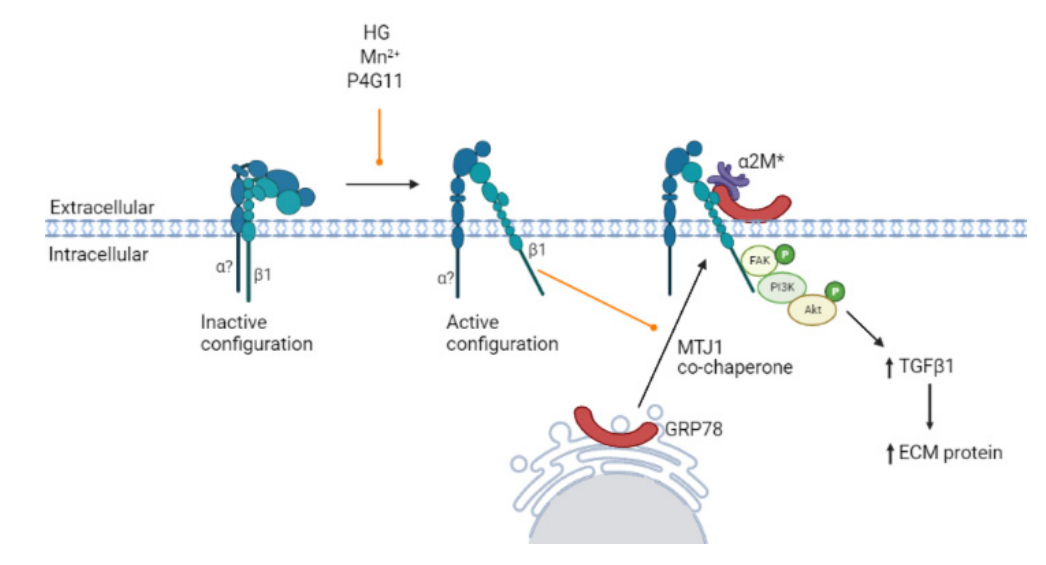
Figure 8. Proposed role of integrin β 1 in csGRP78 profibrotic signaling in response to HG in MCs. HG promotes the presentation of GRP78 on the cell surface in MCs (black arrow). Here, interaction with HG-activated integrin β 1 induces FAK and downstream Akt signaling. This increases TGF β